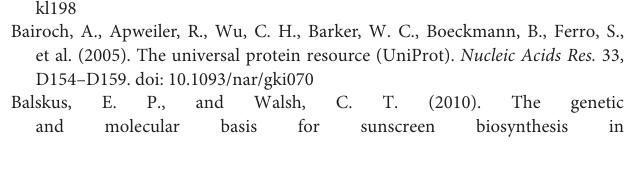
Supplementary Table 1 | Information of 19 teleost fishes used in our present study. Supplementary Table 2 | Accession numbers of known aanat, opsin and neighboring genes. Supplementary Table 3 | Accession numbers of known adjacent genes of eevs and mt-ox. Supplementary Table 4 | Libraries and data yields for the whole genome shotgun sequencing. Supplementary Table 5 | Libraries and data yields for the PacBio sequencing. Supplementary Table 6 | The alignment result of paired-end reads mapping to H. speculiger genome. Supplementary Table 7 | Summary of repeat annotations. Supplementary Table 8 | Classification of repetitive elements. Supplementary Table 9 | Statistics of function annotation. Supplementary Table 10 | Statistics of Non-coding RNAs in the genome. Supplementary Table 11 | Statistics of gene families in 19 teleost fishes. Supplementary Table 12 | Statistics of pairwise alignment among mirrorwing flyingfish, medaka and zebrafish. Supplementary Table 13 | KEGG enrichment for genes of expanded gene families of the mirrorwing flyingfish. Supplementary Table 14 | Estimated maximal absorption spectrum (?max) of LWS. Supplementary Table 15 | Copy numbers of intact OR genes in each group of fishes and